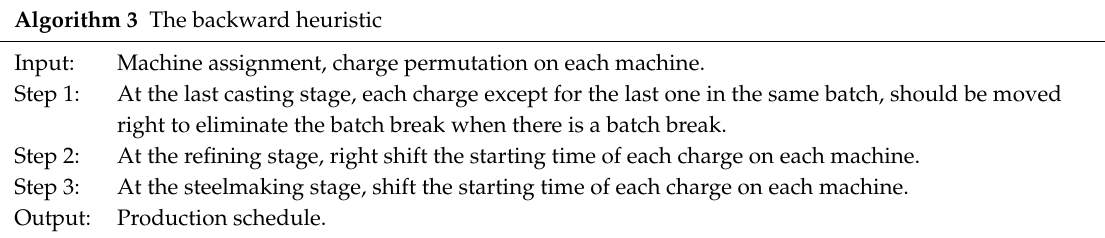
Algorithm 3 The backward